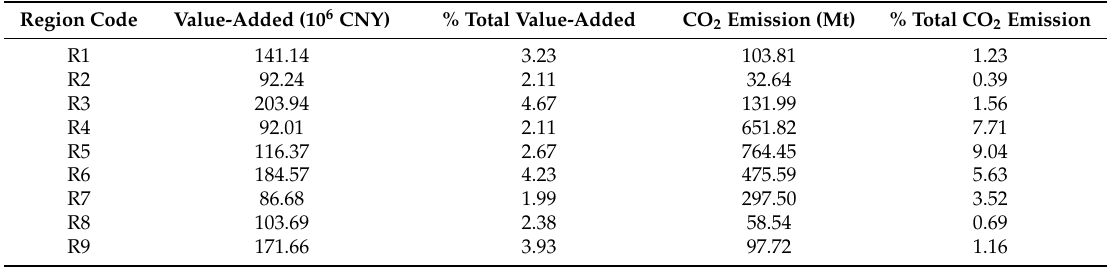
Table 4. The value-added and CO 2 emission of China’s 30 regions in